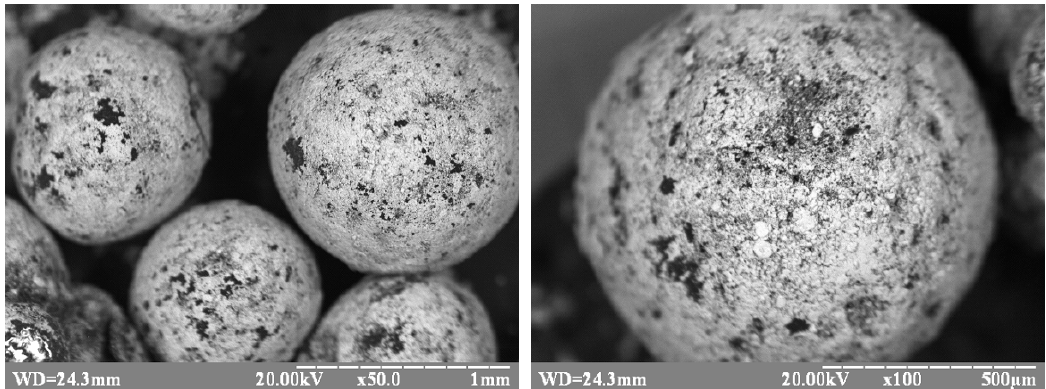
Table 4. Metallization efficiency of washed activated polypropylene.